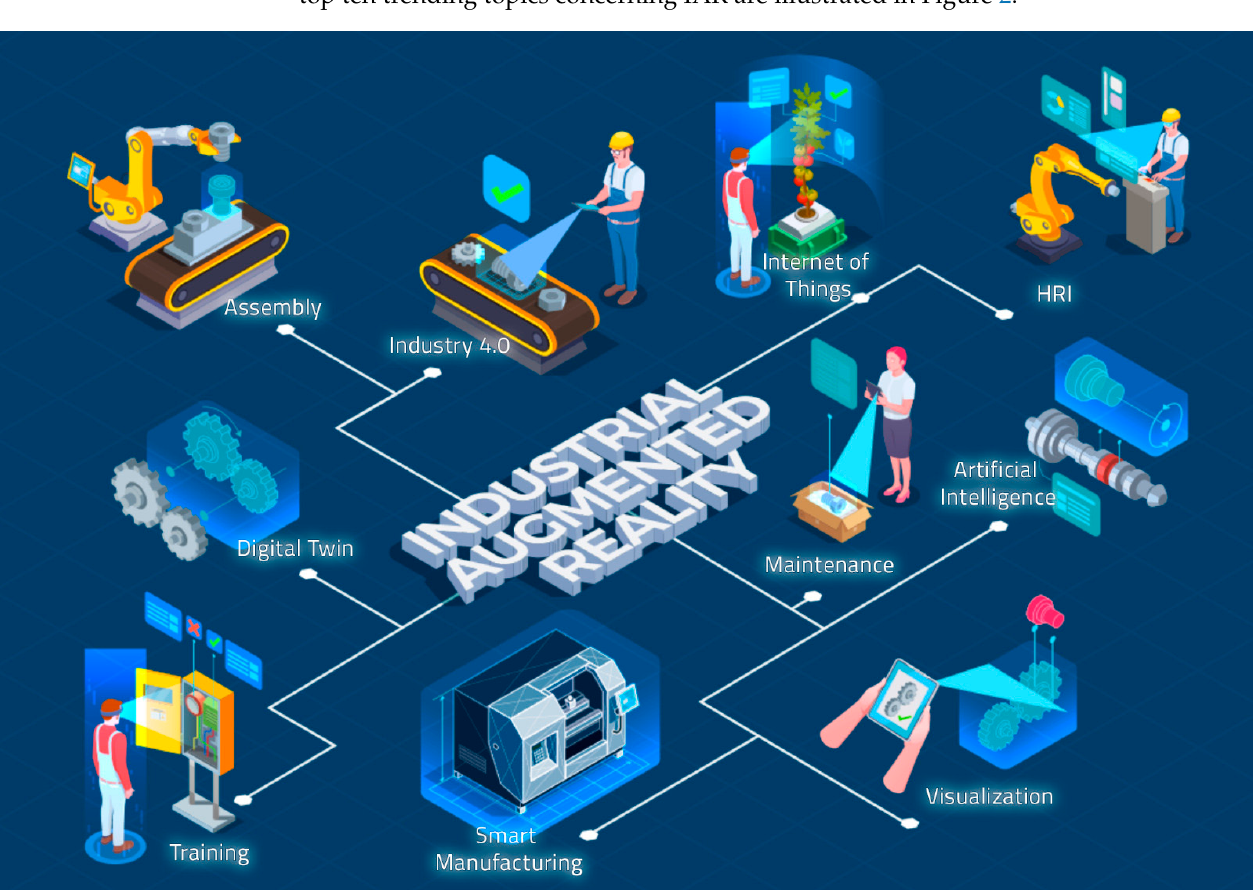
Figure 2. Industrial augmented reality (IAR) trends .